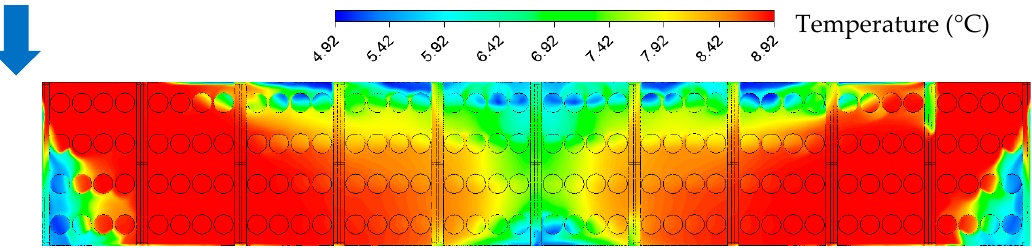
Figure 18. Velocity streamlines and temperature contour at row 17, real field and west wind condition.